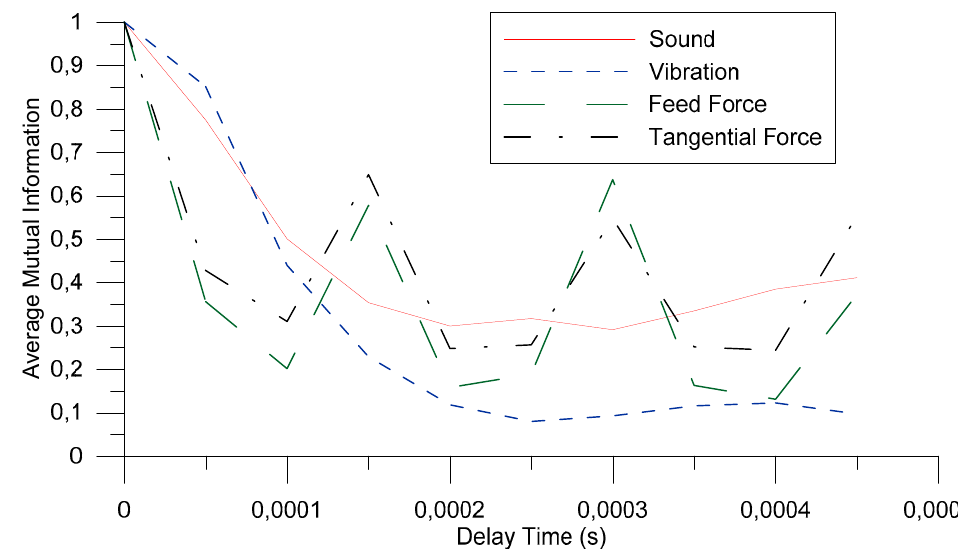
Figure 3. Average mutual information of acquired sensor data for new inserts versus time lag.